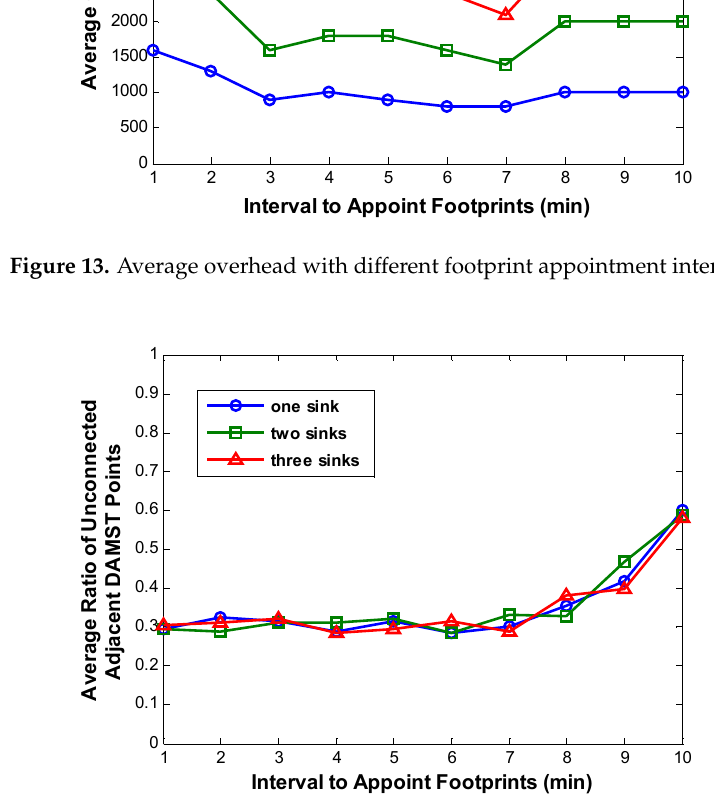
Figure 14. Average ratios of unconnected adjacent DAMST points with different footprint appointment intervals.